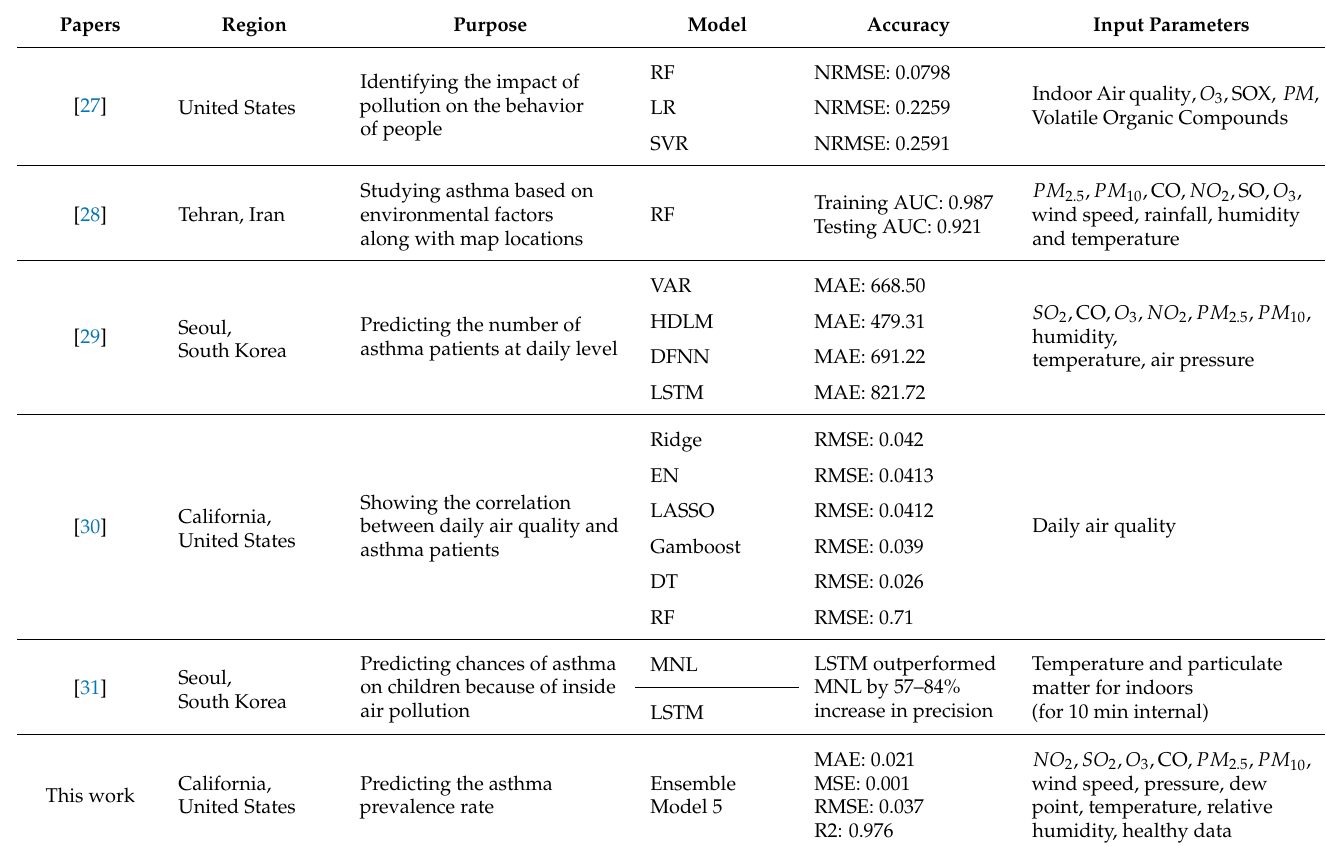
Table 11. Comparison of Health Prediction Models (created by